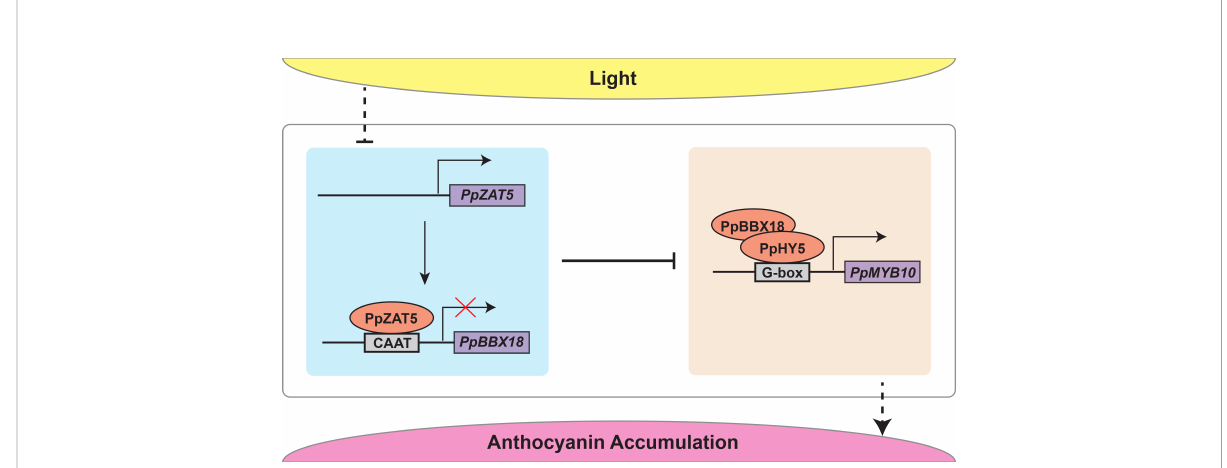
FIGURE 6 The proposed model indicates that under continuous light treatment, PpZAT5 downregulates the expression of PpBBX18 by directly bound to its promoter and ultimately represses the signaling of light-induced anthocyanin accumulation in